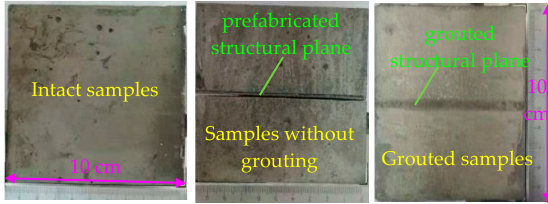
Figure 4. Prefabricated mortar block with structural surface. Table 2. The shearing experiment